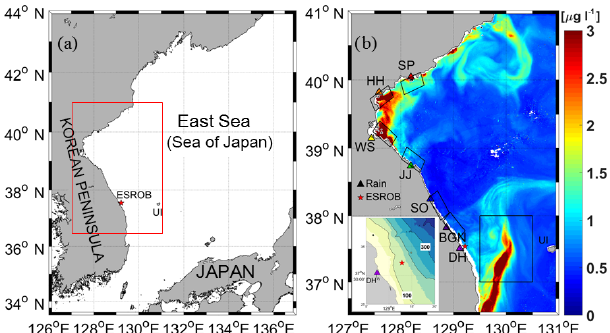
Figure 1. (a) Study area in the western East Sea (Sea of Japan). (b) A chlorophyll a (Chl a ) image from the geostationary ocean color satellite on 6 September 2012 in the area marked by a red box in (a) . Black solid boxes denote the areas where the Chl a and TSS are averaged. Locations of the rainfall stations along the east coast of the Korean Peninsula are marked by triangles (SP: SinPho, HH: HamHeung, WS: WonSan, JJ: JangJun, SO: Sockcho, BGN: Buk- GangNeung, DH: DongHae, rainbow-colored). The surface moor- ing (ESROB) is indicated by a red star in (b) with bottom topogra- phy in the lower left corner, where numbers denote water depth in meters (contour interval: 100m). Ulleung Island (UI) is located at ∼ 131 ◦